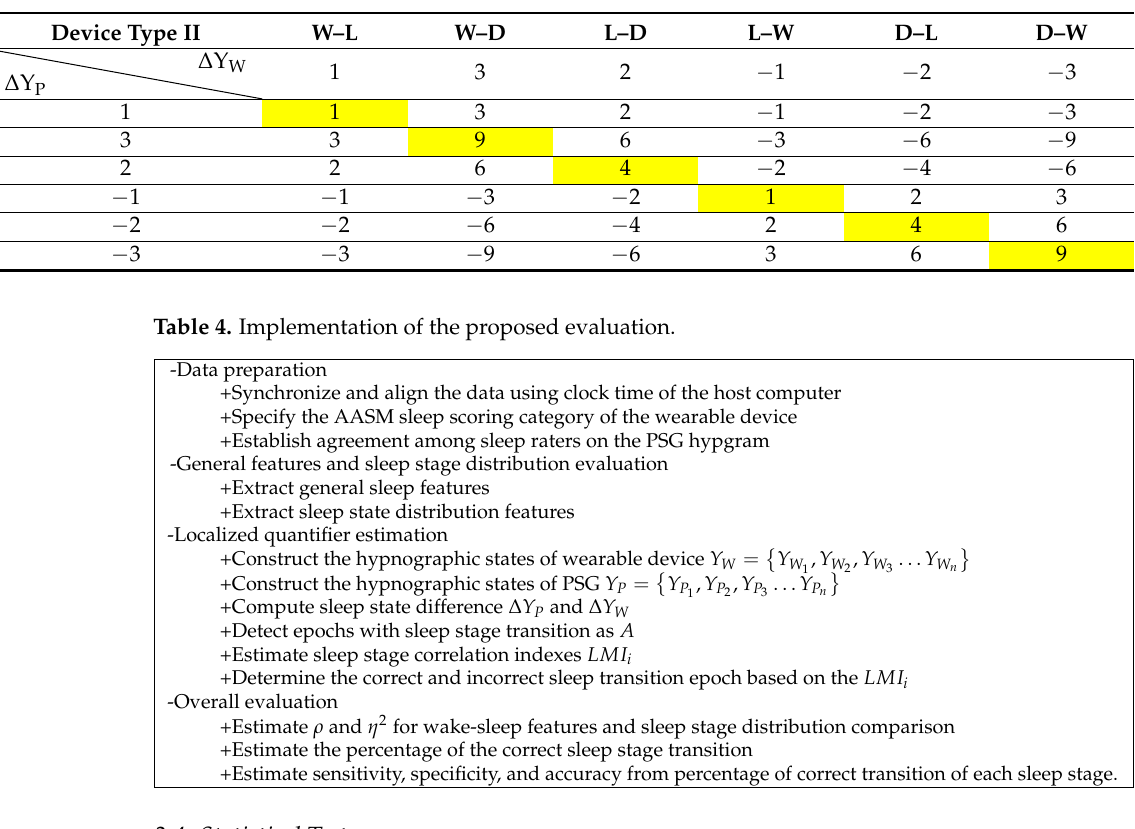
Table A1 in the Appendix A. Table 3. The localized mismatch index values between wearable Device type II and PSG with “W” annotated for Wake, “L” for Light, “D” for Deep, and the operation ‘-‘ for the transition between sleep stage (i.e., W–L is Wake to Light transition). LMI Value